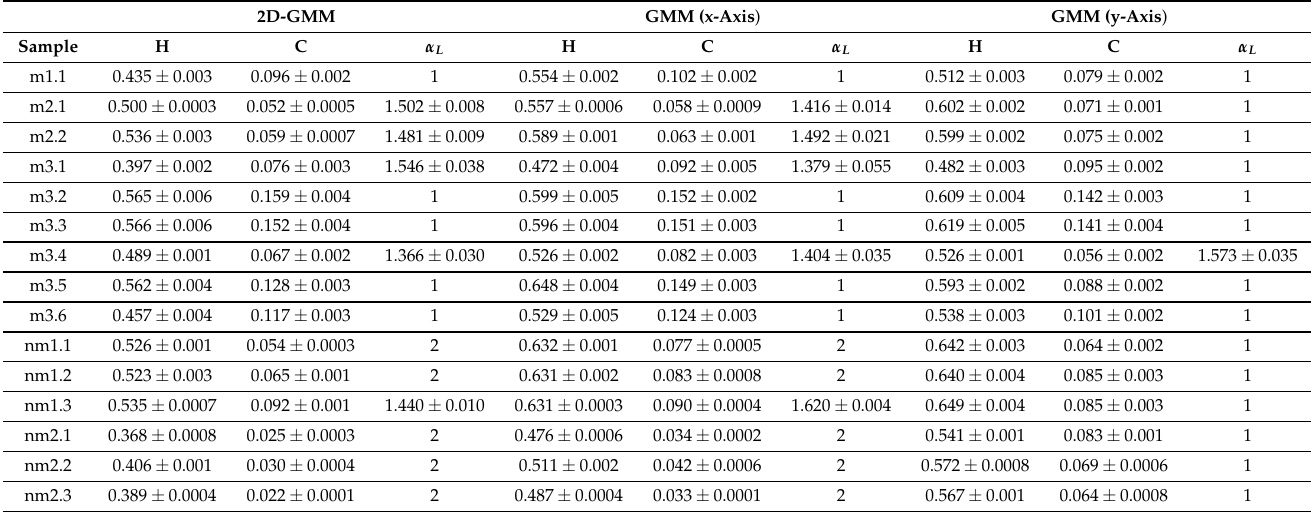
C ( q 2 q ) log-normal for α L = 2, or − −